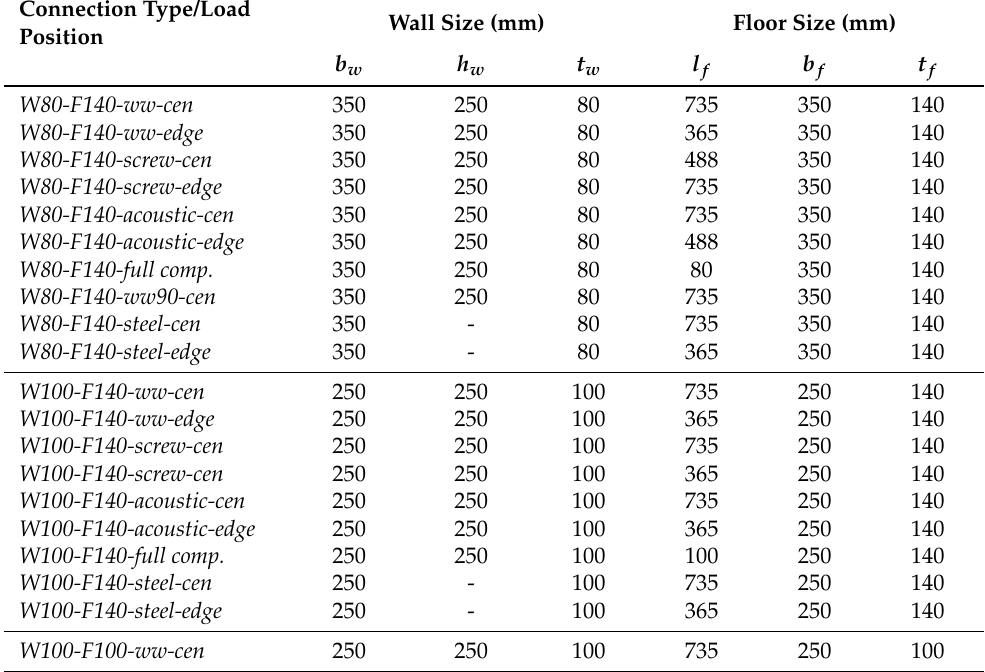
Table 1. Dimension of test